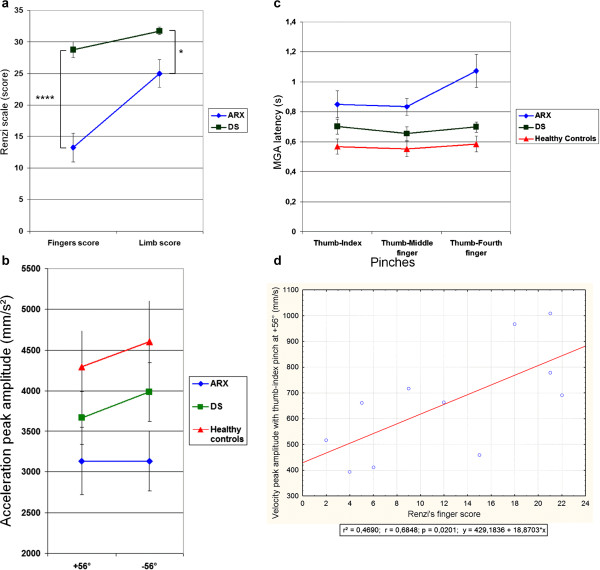
Kinematic results. a: Significant [object orientation*group] interaction on acceleration peak amplitude [F(2,32) = 3.45, p < 0.05]: a significant orientation effect was observed in healthy controls and DS patients but not in ARX patients; b: Significant [Pinch*group] interaction on MGA latency [F(4,64) = 7.06, p < 0.001]: ARX patients were impaired in using the thumb-fourth finger pinch; c: Significant positive correlation between the velocity peak amplitude with the thumb-index pinch at +56° and the De Renzi’s finger score.